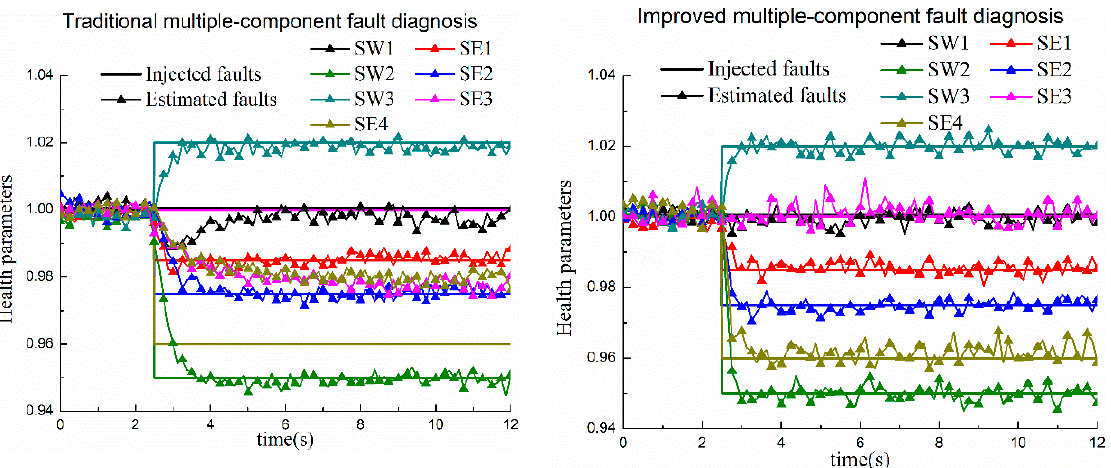
Figure 17. Comparison of the traditional and improved methods for multiple-component fault diagnosis.